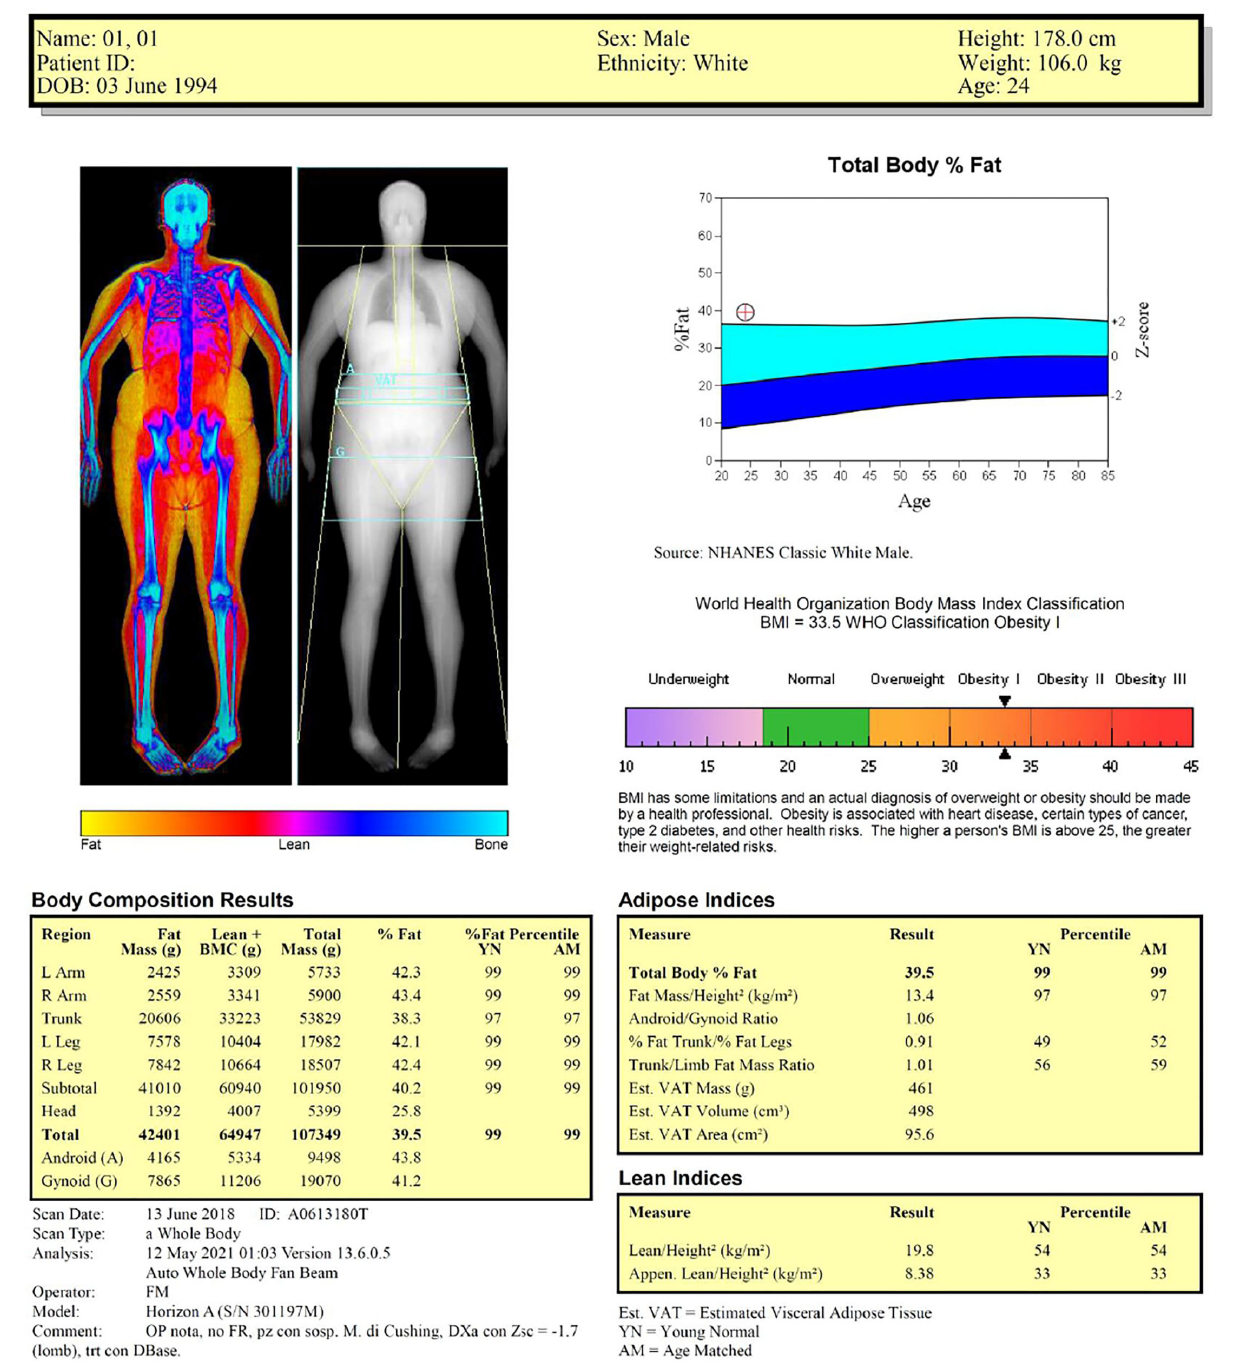
Frontiers in Rehabilitation Sciences |